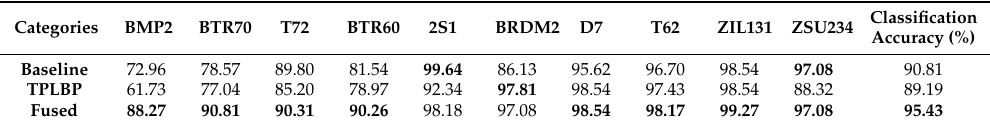
Table 3. The classification accuracy of raw features and fused features.